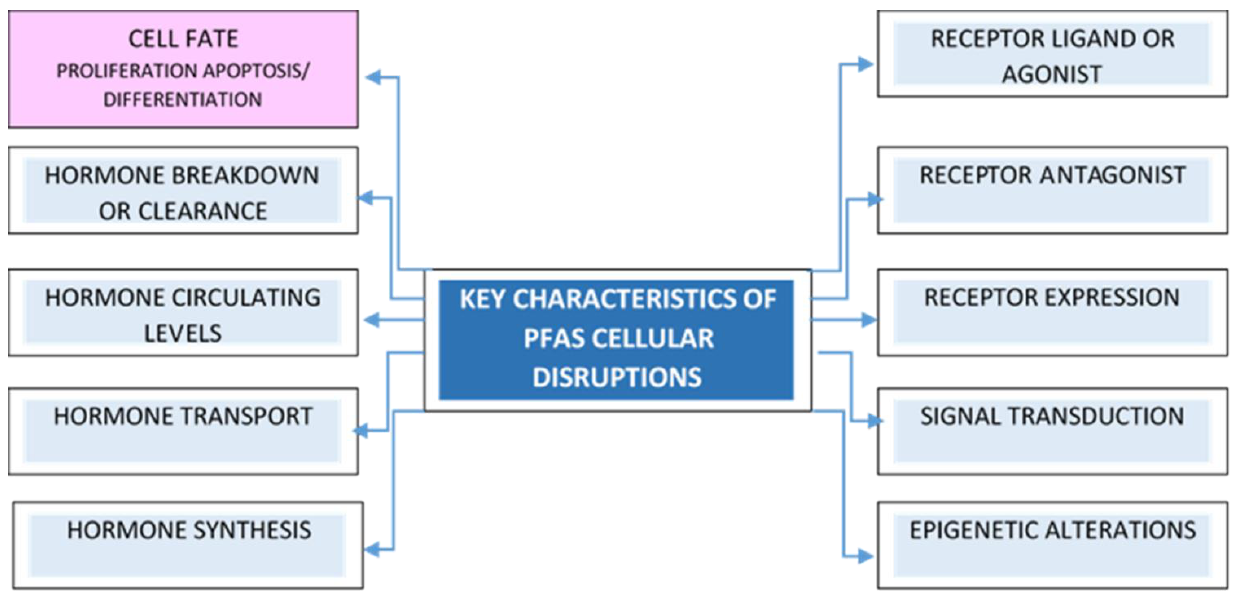
Figure 2. The key characteristics of potential PFAS cellular disruptions for hazard identification.